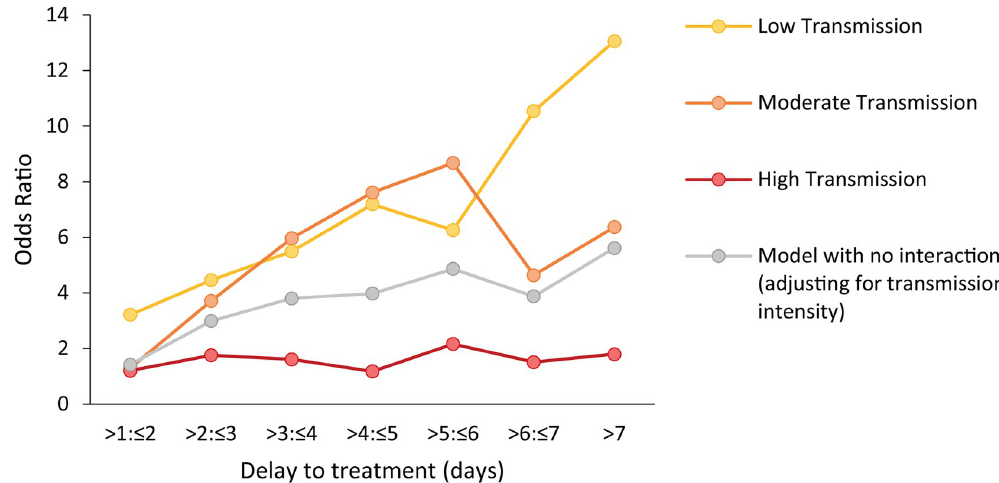
Fig 6. Association between delay to treatment and SMA for different levels of transmission intensity in children < 15 years. ORs for the association between duration of illness and SMA from 2 age-adjusted mixed-effects models: one adjusting for transmission intensity level and one accounting for an interaction between transmission intensity and delay. Transmission intensity was categorised into low ( Pf PR 2–10 < 10%), moderate ( Pf PR 2–10 10% to < 35%), and high ( Pf PR 2–10 � 35%). CIs around the OR estimates are shown in S10 Table. OR, odds ratio; SMA, severe malarial